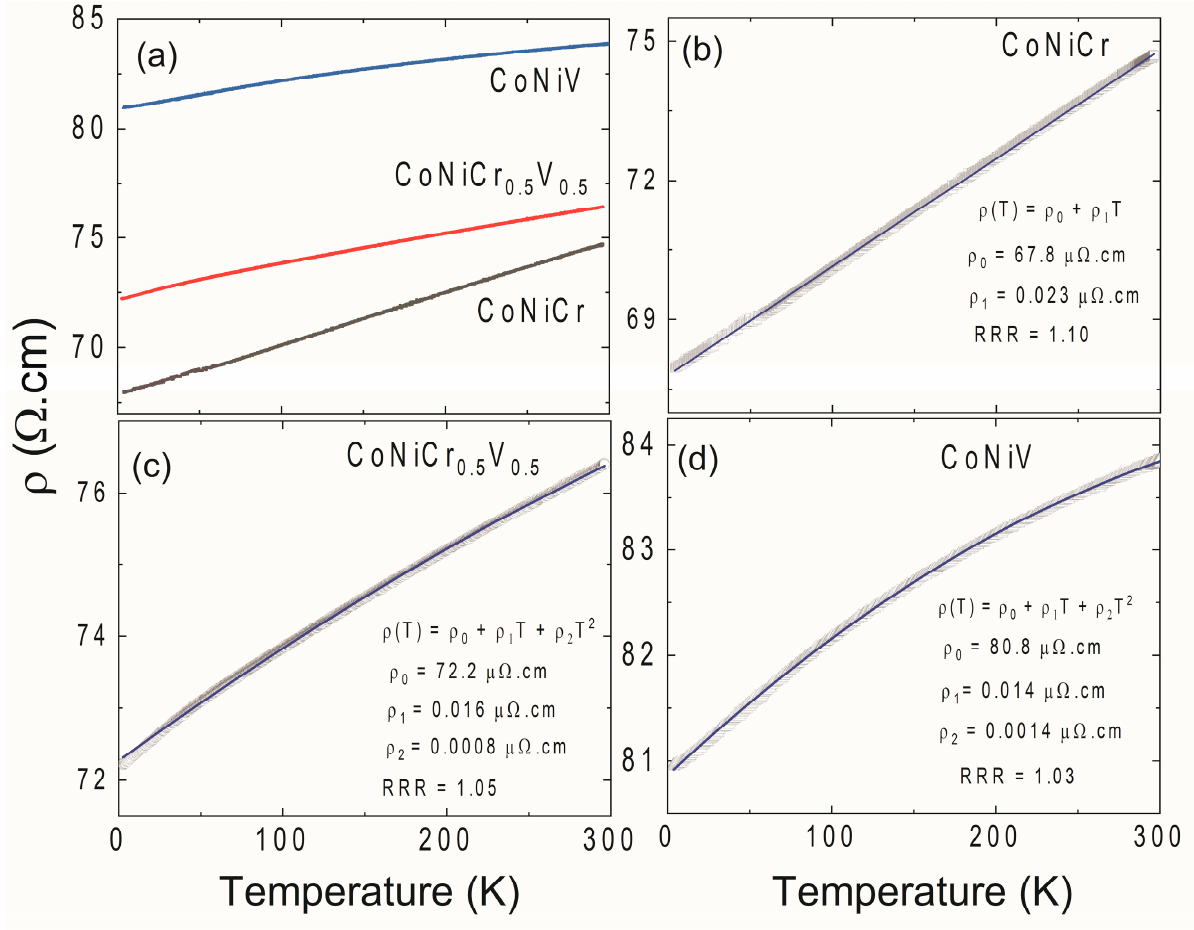
Figure 7. ( a ) The temperature dependence of the resistivity measured in the range of 2–300 K. ( b – d ) The power law fits to various models. The solid lines are fits to the expressions in the panel.